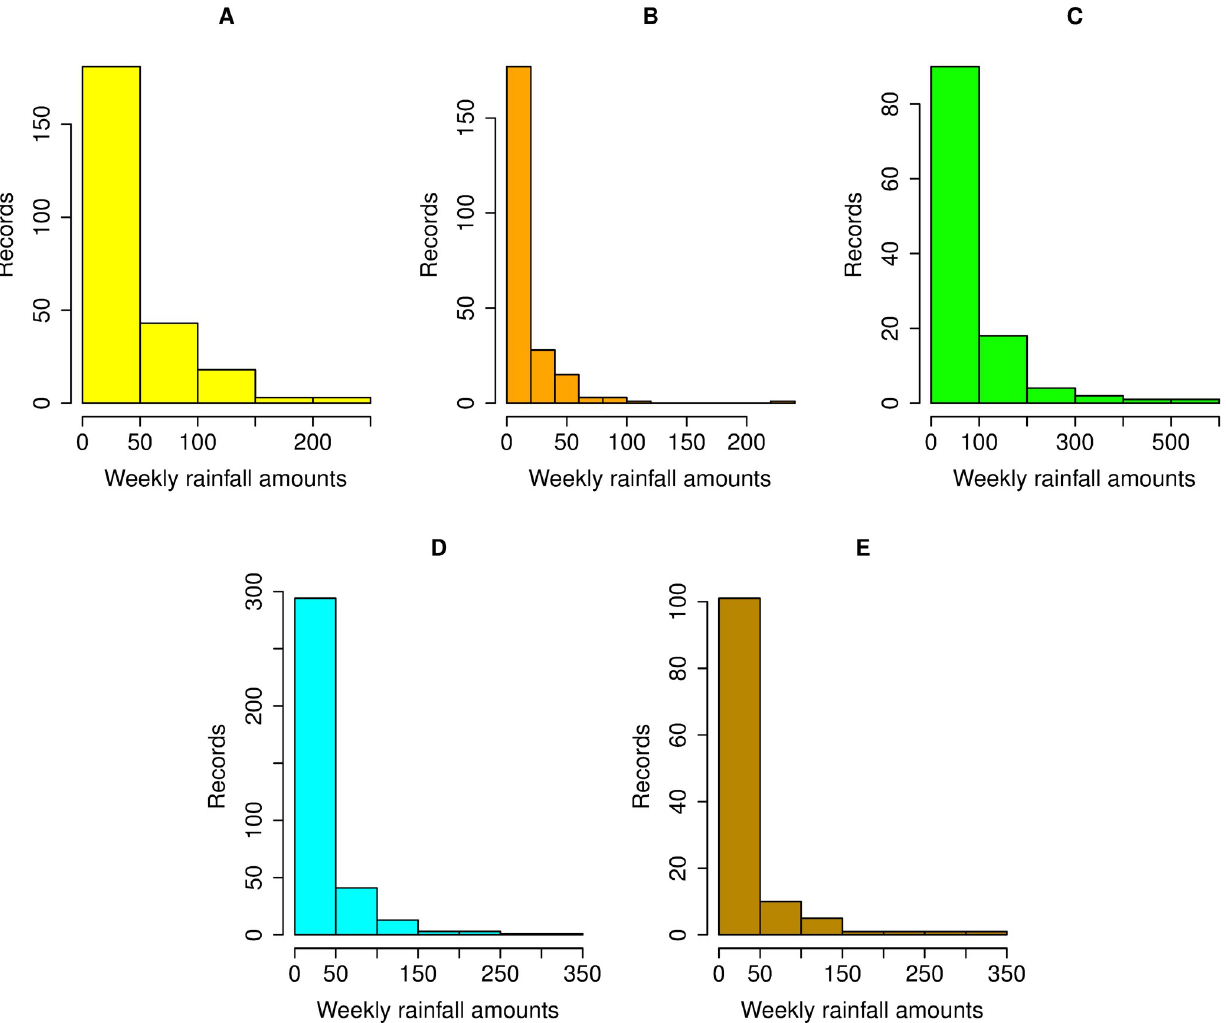
Fig 3. Histogram plots of weekly rainfall records in five parts. (A) Northern (B) Central (C) Eastern (D) Southeastern (E)